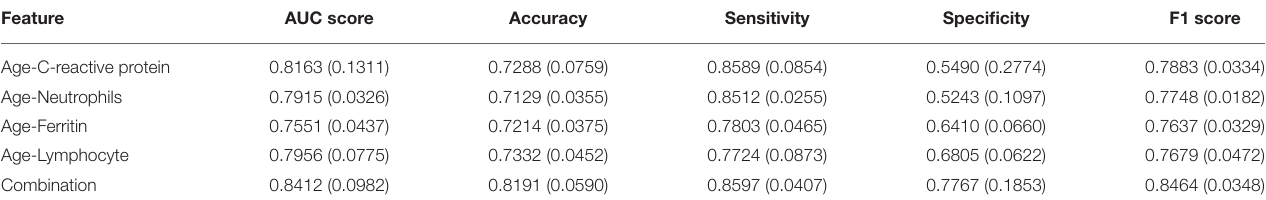
TABLE 6 | Results of combined feature models.